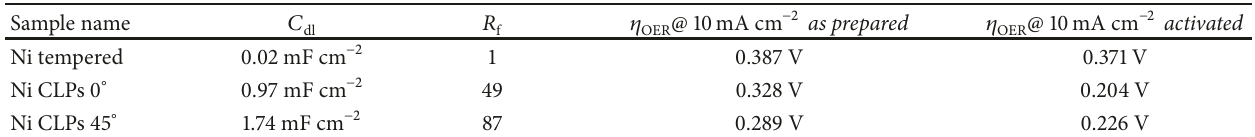
Table 2: Overview of key indications: double layer capacitance 𝐶 dl and the corresponding roughness factor 𝑅 f as well as the oxygen evolution overpotential 𝜂 OER @ 10mA cm −2 of the tempered Ni electrode and the laser-structured samples Ni CLPs 0 ∘ and Ni CLPs 45 ∘ as prepared and activated .